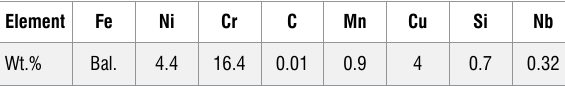
Processing parameters used for manufacturing the specimens Laser power Sample (W)